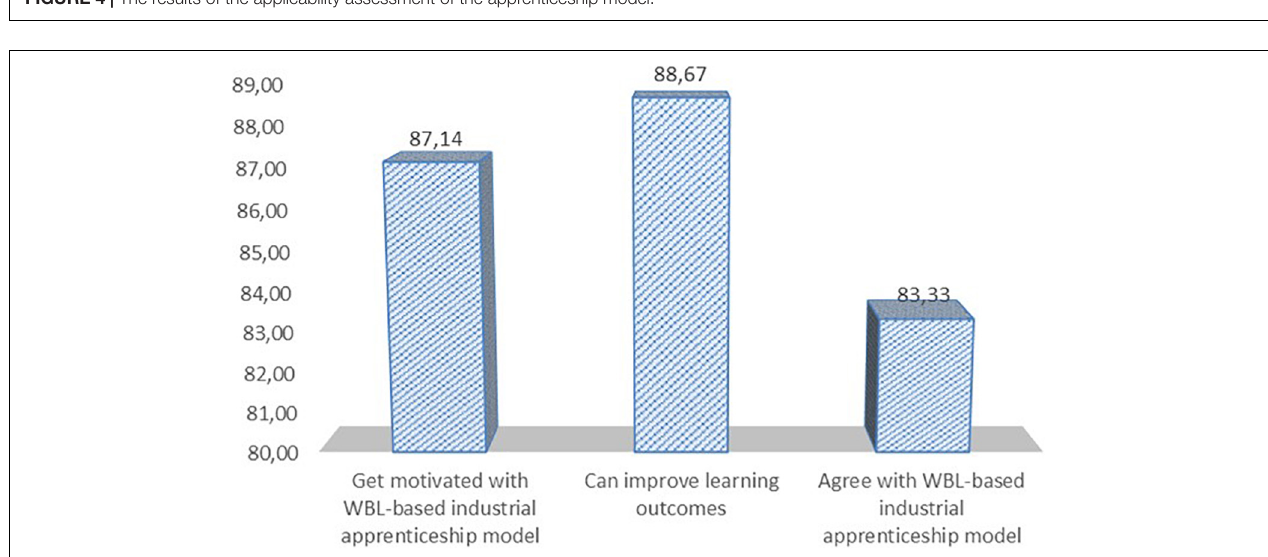
FIGURE 4 | The results of the applicability assessment of the apprenticeship model.